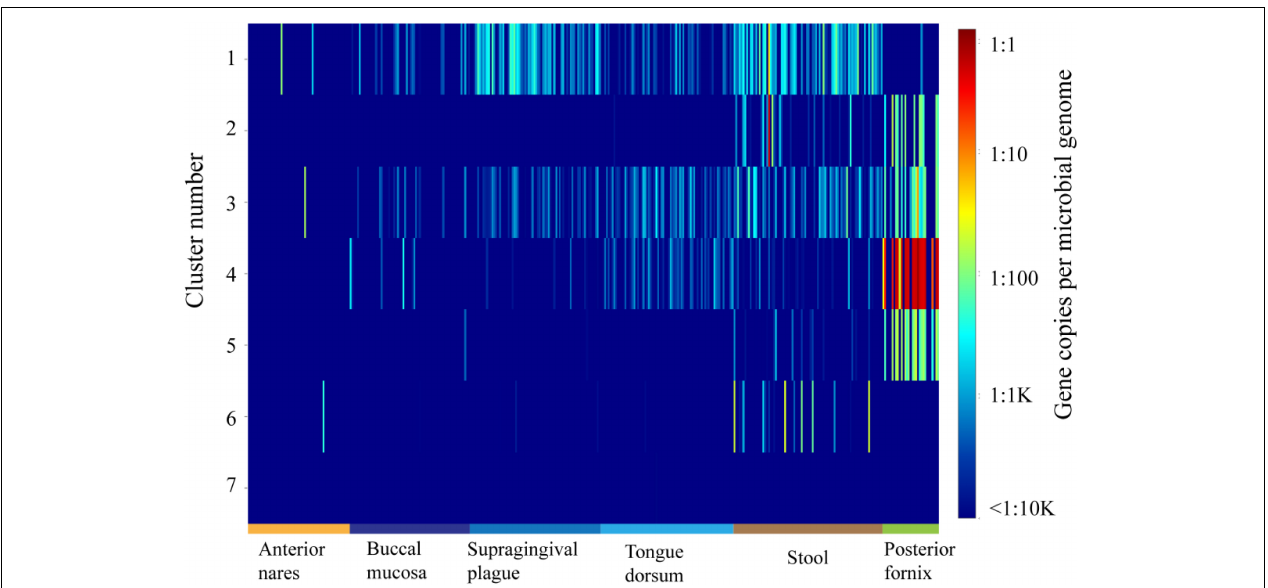
FIGURE 4 | The abundance and distribution of the 7 oxalyl-coenzyme A decarboxylase (OXC) clusters in 378 HMP metagenomes from six body sites as quantified using ShortBRED.